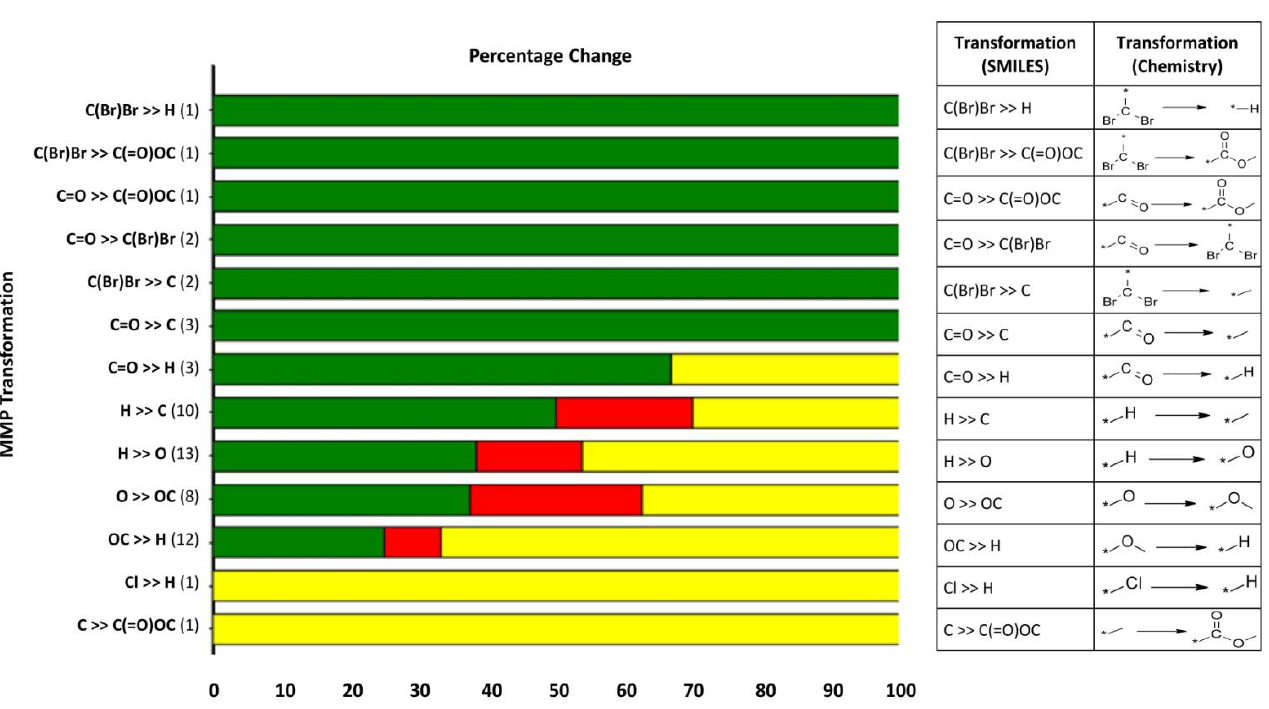
Figure 3. MMPs analysis— bar graph of the MMP transformations versus % that affects activity. Each bar indicates a MMP transformation, and the color coding classifies the activity change: increases activity (green), decreases activity (red), and has neutral effect on activity (yellow). The labels on the left axis indicate the type and number of transformations. Additionally, a table on the right side contains the SMILES transformation and a sketch of the associated reaction. In order to abbreviate the large structures of the tested molecules, * represents the rest of the molecule.